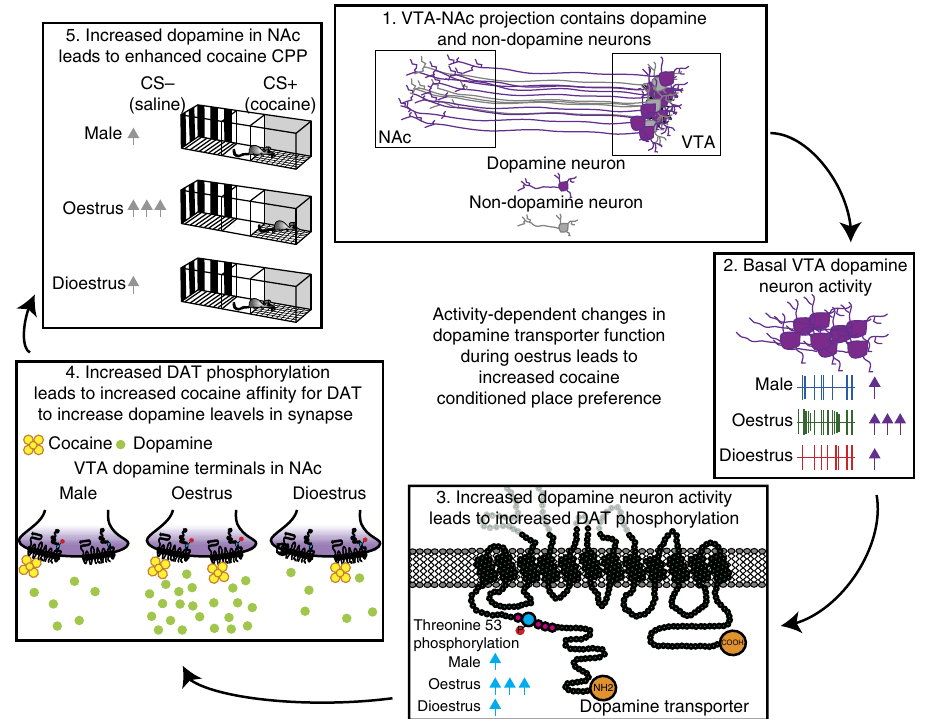
Figure 6 | Proposed schematic highlighting a potential mechanism for the activity-dependent changes in reward processing that occur during oestrus. (1) The VTA to NAc pathway comprises dopaminergic neurons (purple) and other neuronal subpopulations (grey). (2) Dopamine neuron firing is enhanced during oestrus. (3) The increased activity of this pathway leads to downstream ERK activation and concomitant phosphorylation of Thr53 (blue) on DAT. (4) These changes in DAT lead to alterations in cocaine affinity, whereby cocaine is more able to bind to DATand increase extracellular dopamine levels. This increased cocaine binding leads to increased dopamine levels in the NAc. (5) In vivo this drives increased associations between cocaine and contextual cues, which leads to enhanced cocaine CPP due to differences in the perceived rewarding value of